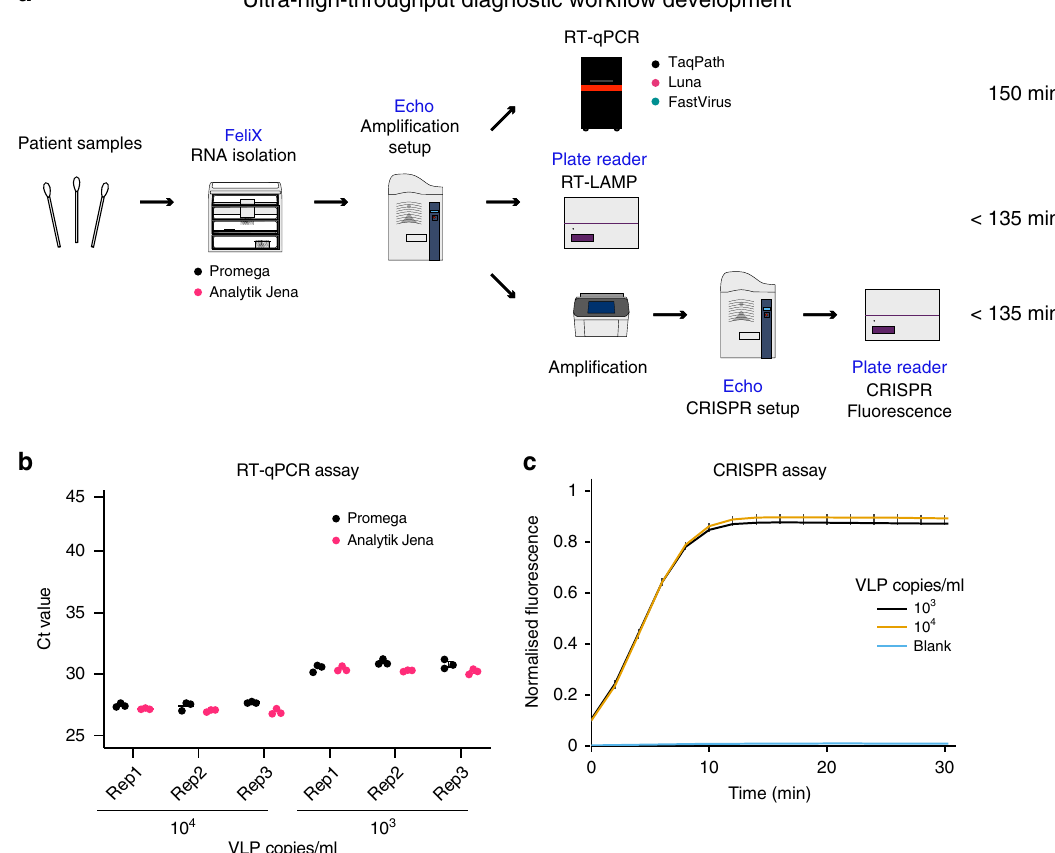
Fig. 4 SARS-CoV-2 platform development using the MS2-SARS-CoV-2 VLP standard. a Schematic of the modular platform for the detection of SARS- CoV-2. Viral RNA is isolated using the Analytik Jena FeliX liquid handler with the Analytik Jena or Promega RNA extraction kits. Sample RNA is transferred and detection reactions are set up using the Labcyte Echo platform. These include qPCR, validated for the TaqPath (Thermo Fisher Scienti fi c), Luna (NEB), and Fast Virus (Thermo Fisher Scienti fi c) RT-qPCR master mix options, RT-LAMP nucleic acid detection, and the CRISPR-Cas13a diagnostic work fl ow. b Automated RNA extraction was developed using VLP dilutions of 10 3 and 10 4 copies/mL for the Analytik Jena and Promega RNA extraction kits. Ef fi ciency of the extractions using both kits was analysed by RT-qPCR with the CDC N1 primer – probe set using the TaqPath master mix. c Dilutions of VLPs used for RT-qPCR in b were analysed using the CRISPR NAT to demonstrate the use of this work fl ow as an alternative diagnostic option. Error bars in b represent mean ± SE of n = 3 biologically independent samples with three technical replicates. Error bars in c represent mean ± SE of n = 3 independent ampli fi cation replicates and four technical replicates for CRISPR detection. Source data are available in the Source Data fi